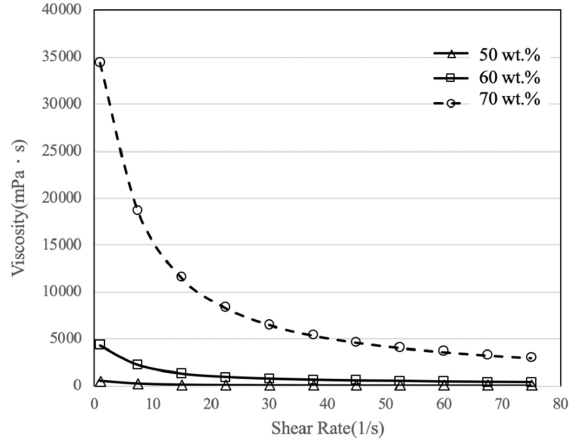
Figure 7. Viscosity curves for three types of zirconia slurry.